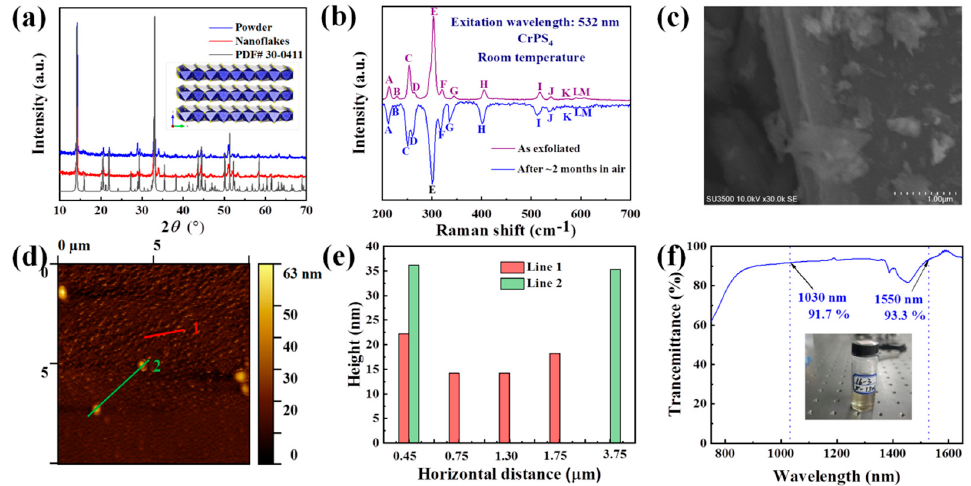
Figure 3. Characterizations of as-synthesized CrPS 4 nanoflakes after liquid-phase exfoliation: ( a ) the XRD patterns of CrPS 4 ; ( b ) the Raman spectrum of few-layer CrPS 4 nanoflakes on a Si substrate; ( c ) SEM image of CrPS 4 ; ( d , e ) AFM image of few-layer CrPS 4 nanoflakes on a Si substrate and corresponding height profile ( The red line and the green line represent the positions of the measured material thickness in the sample); ( f ) UV/Vis/NIR absorption spectrum of few-layer CrPS 4 nanosheets in NMP.